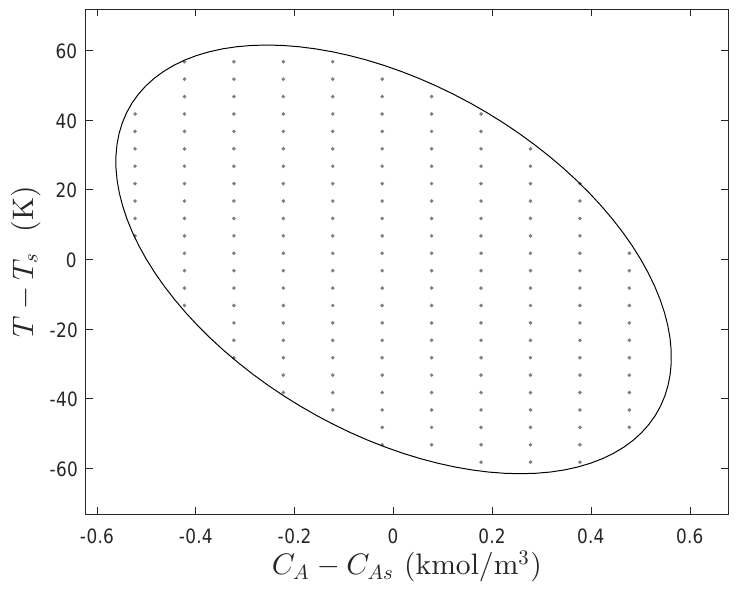
Figure 7. Initial states in the stability